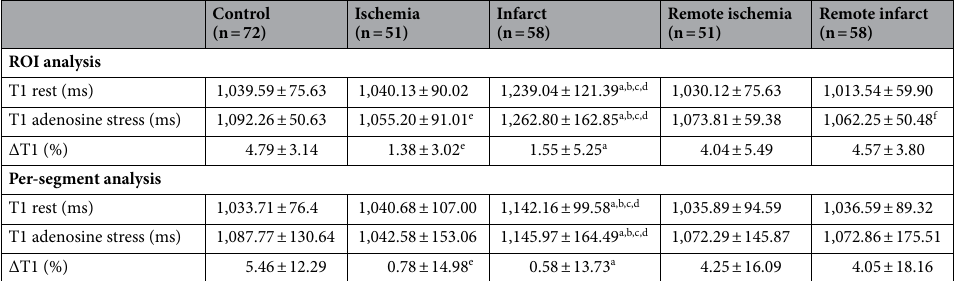
Table 3. Myocardial T1 characteristics from different groups of the study population with suspected CAD. Data presented in mean ± standard deviation. A p -value < 0.05 indicates statistical significance. CMR cardiac magnetic resonance, SD standard deviation; ms, milliseconds. a Statistical significance between infarct and control. b Statistical significance between infarct and ischemia. c Statistical significance between infarct and remote ischemia. d Statistical significance between infarct and remote infarct. e Statistical significance between ischemia and control. f Statistical significance between remote infarct and control.